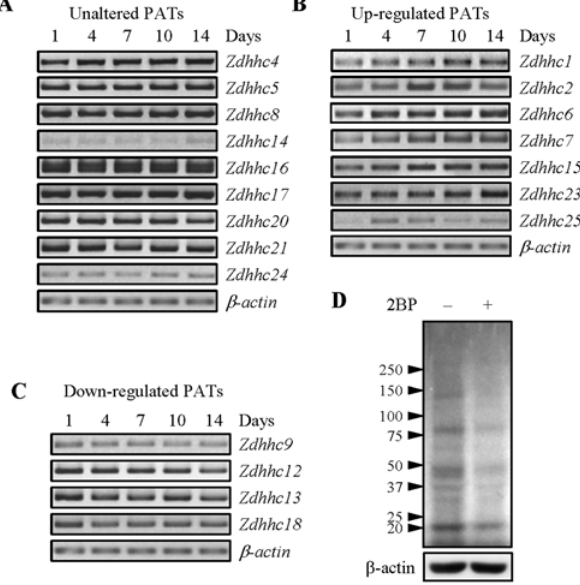
Figure 1. Expression of PATs and protein palmitoylation in osteoblasts. A. RT-PCR analysis of the mRNA levels of the 24 known PATs during osteoblast differentiation. Primary osteoblasts were cultured in the differentiation medium for different periods of time. Total RNA was isolated from these cultures and was then used to carry out RT-PCR. These PATs were classified into unaltered expression (A), increased expression (B), and decreased expression (C), in comparison to the day 1 cultures. D. 2BP was able to inhibit protein palmitoylation in primary osteoblasts. Primary osteoblasts were treated with 100 m M of 2BP for 2 hrs and then 3 H-palmitic acid was included in the culture medium for 24 hrs. The cells were harvested and the same amounts of total proteins were loaded for control and 2BP treated samples. The SDS-PAGE gel was dried and exposed to x-ray films. The palmitoylated proteins are radio-labeled. Actin was used as a loading control.